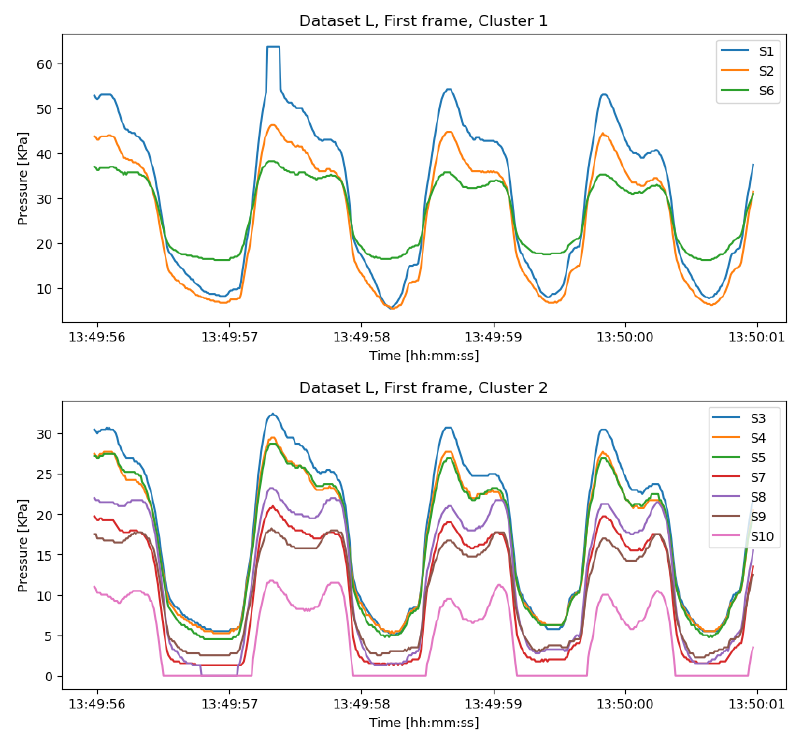
Figure 8. Cluster1 and Cluster2 of the first data frame from dataset L in the posterior